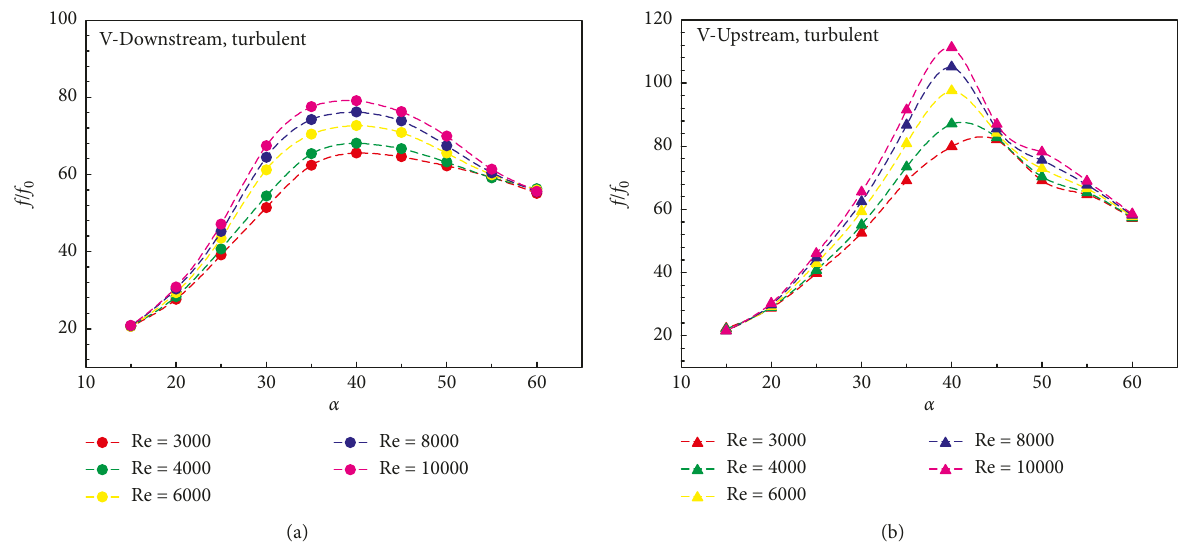
Figure 25: Relations of f / f 0 with α for the heat exchanger tube inserted with the V-wavy surface for (a) V-Downstream and (b) V-Upstream at the turbulent